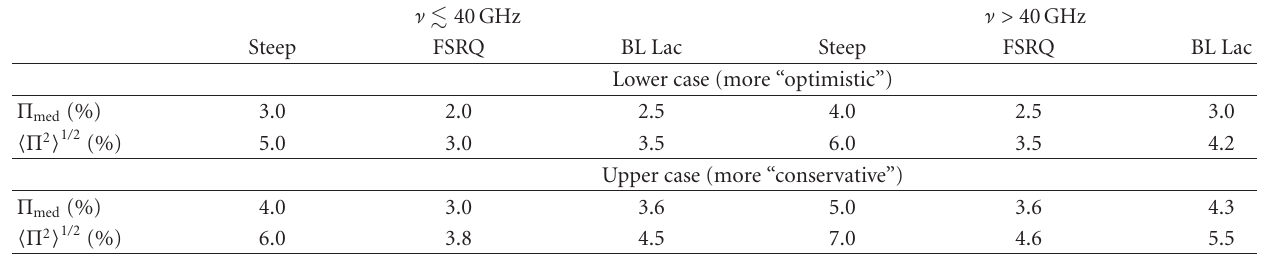
Table 4: Median and dispersion of the log-normal distribution for the fractional polarization, Π , as a function of frequency and for the di ff erent radio source populations relevant at CMB frequencies. Two cases are considered, a more “optimistic” one and a more “conservative” one (see Section